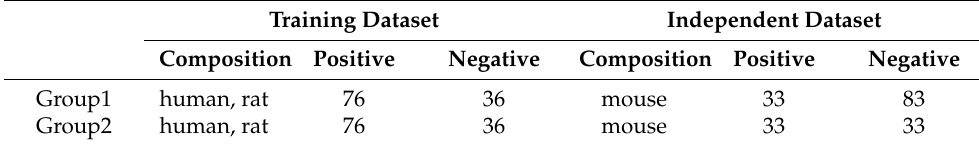
Table 7. Details for each group of independent test